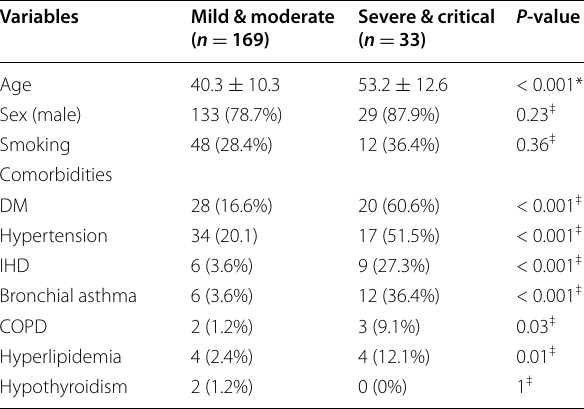
Continuous data represented as mean and SD, and categorical data represented as number and percentage (%).*Independent samples Student’s t -test; ‡ chi- square test; P < 0.05 is significant; DM , diabetes mellitus; IHD , ischemic heart disease; COPD , chronic obstructive pulmonary disease